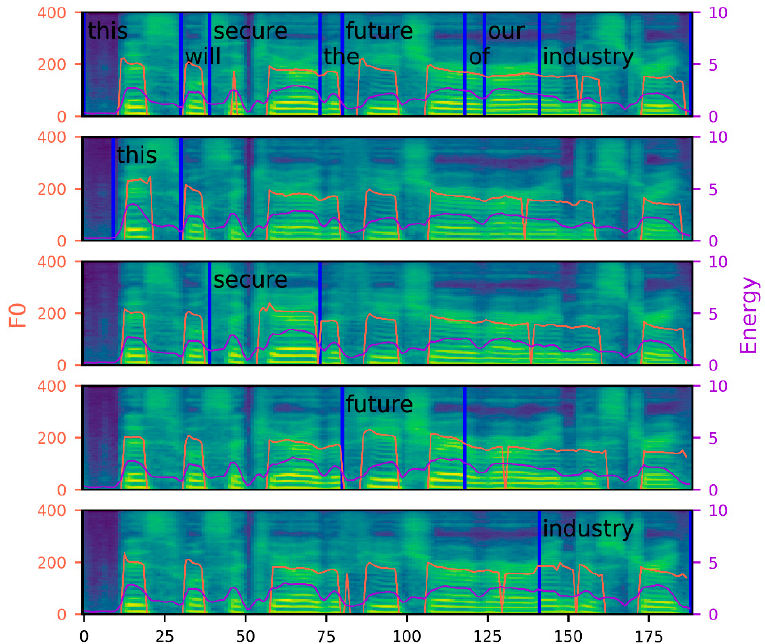
Figure 6. Demonstration spectrums for local prosody emphasis.